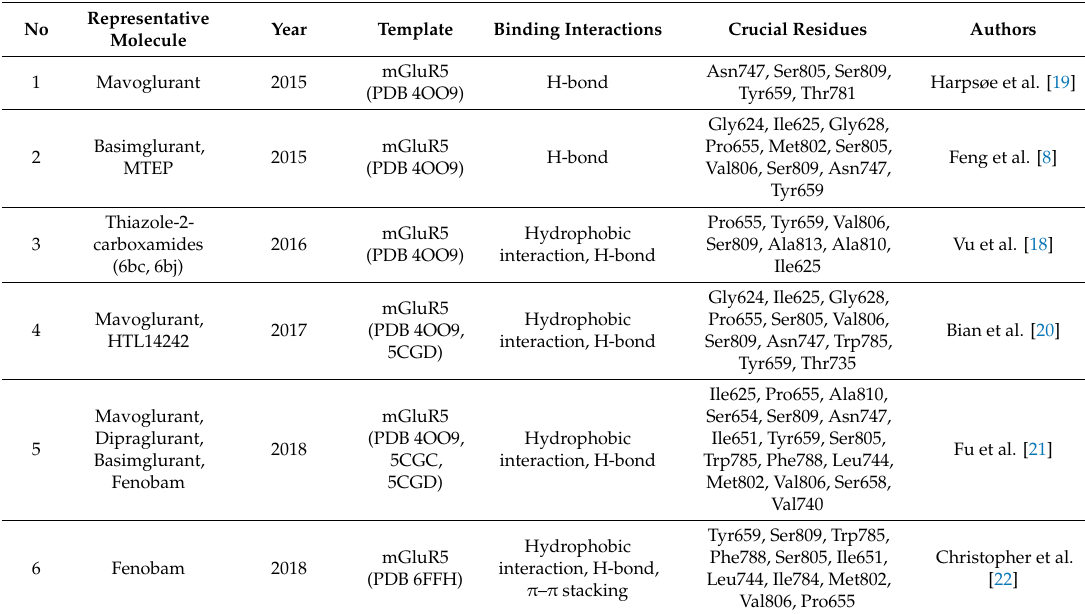
Table 3. The summary of various types of NAMs-mGluR5 docking / MD